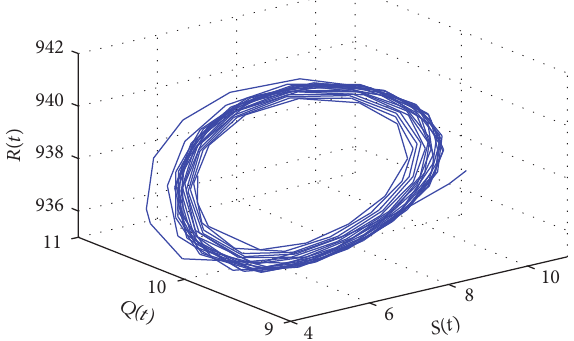
Figure 12: The phase plot of 𝑆 , 𝑄 , and 𝑅 when 𝜏 2 = 1.8625 > 1.7852 = 𝜏 20